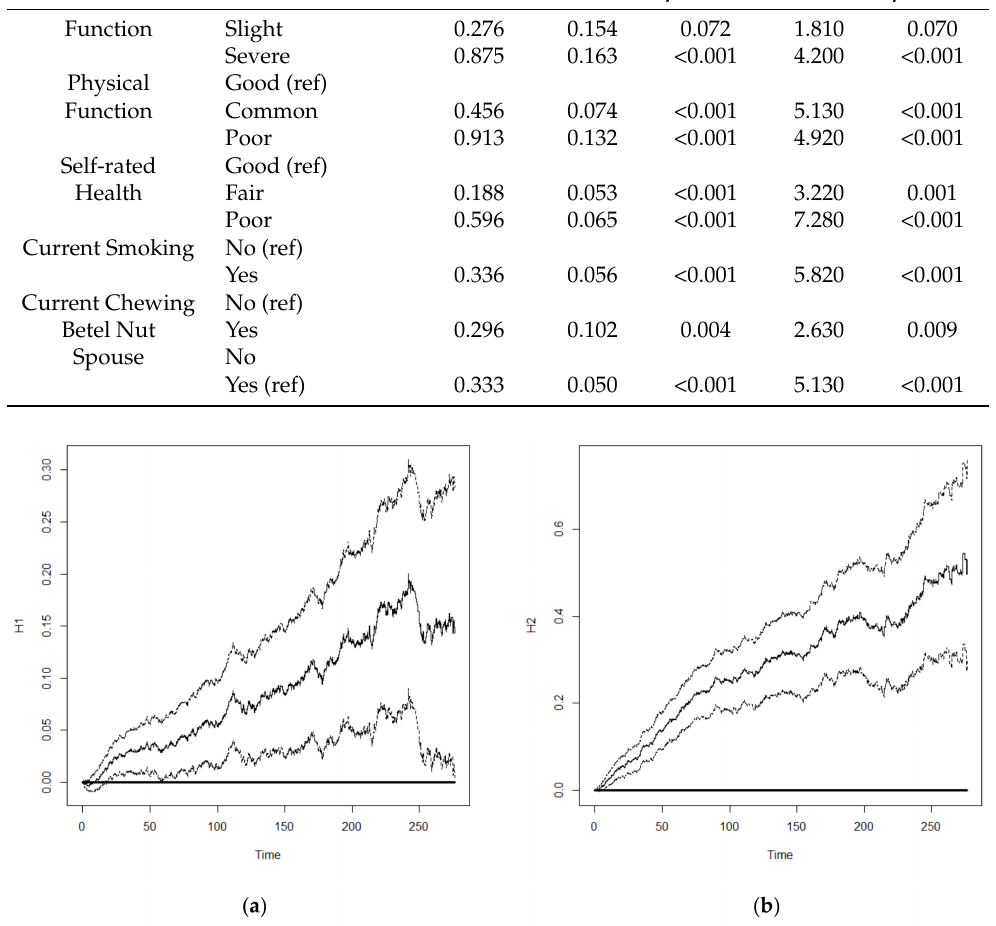
Figure 2. Cumulative regression coefficient and 95% confidence interval: ( a ) Fair self-rated health status; ( b ) Poor self-rated health status.